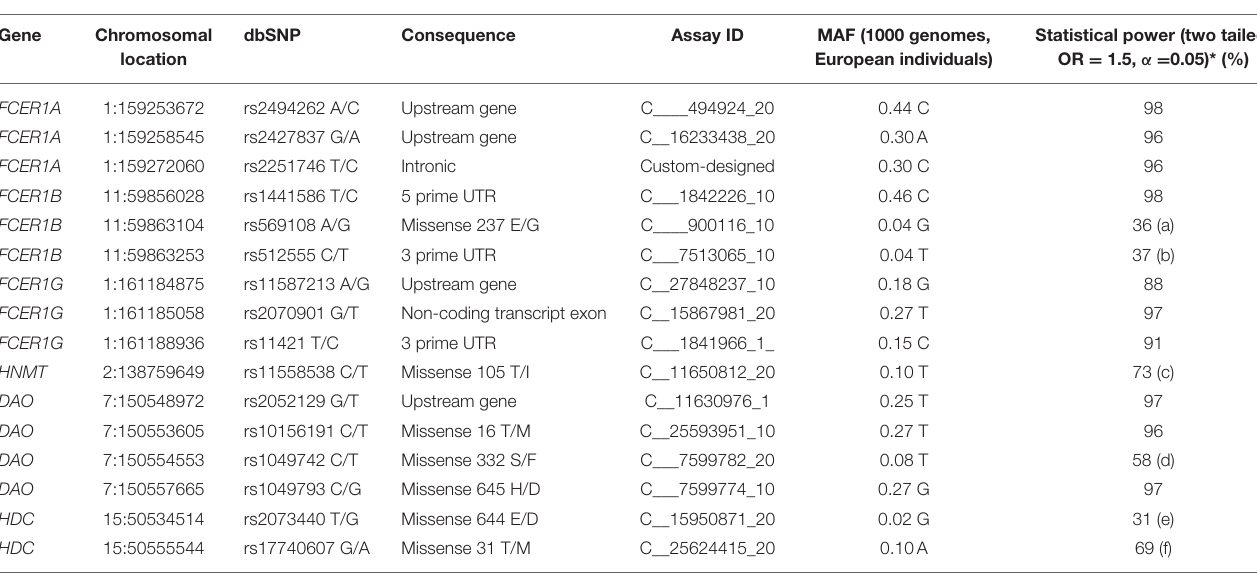
TABLE 4 | SNPs analyzed in this